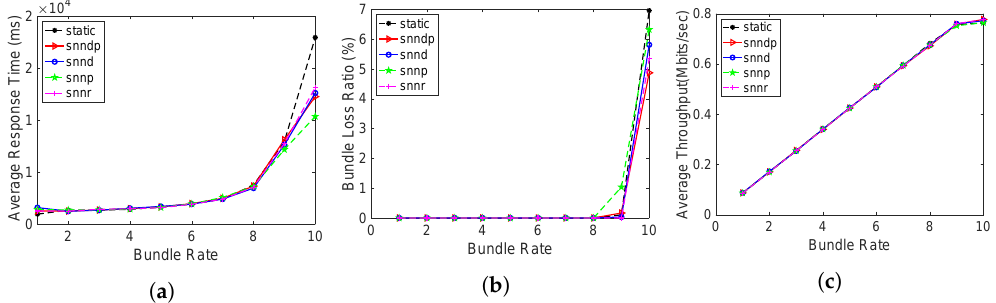
Figure 3. Routing performance: Scenario 1. ( a ) Average response time; ( b ) Packet loss ratio (%); ( c )